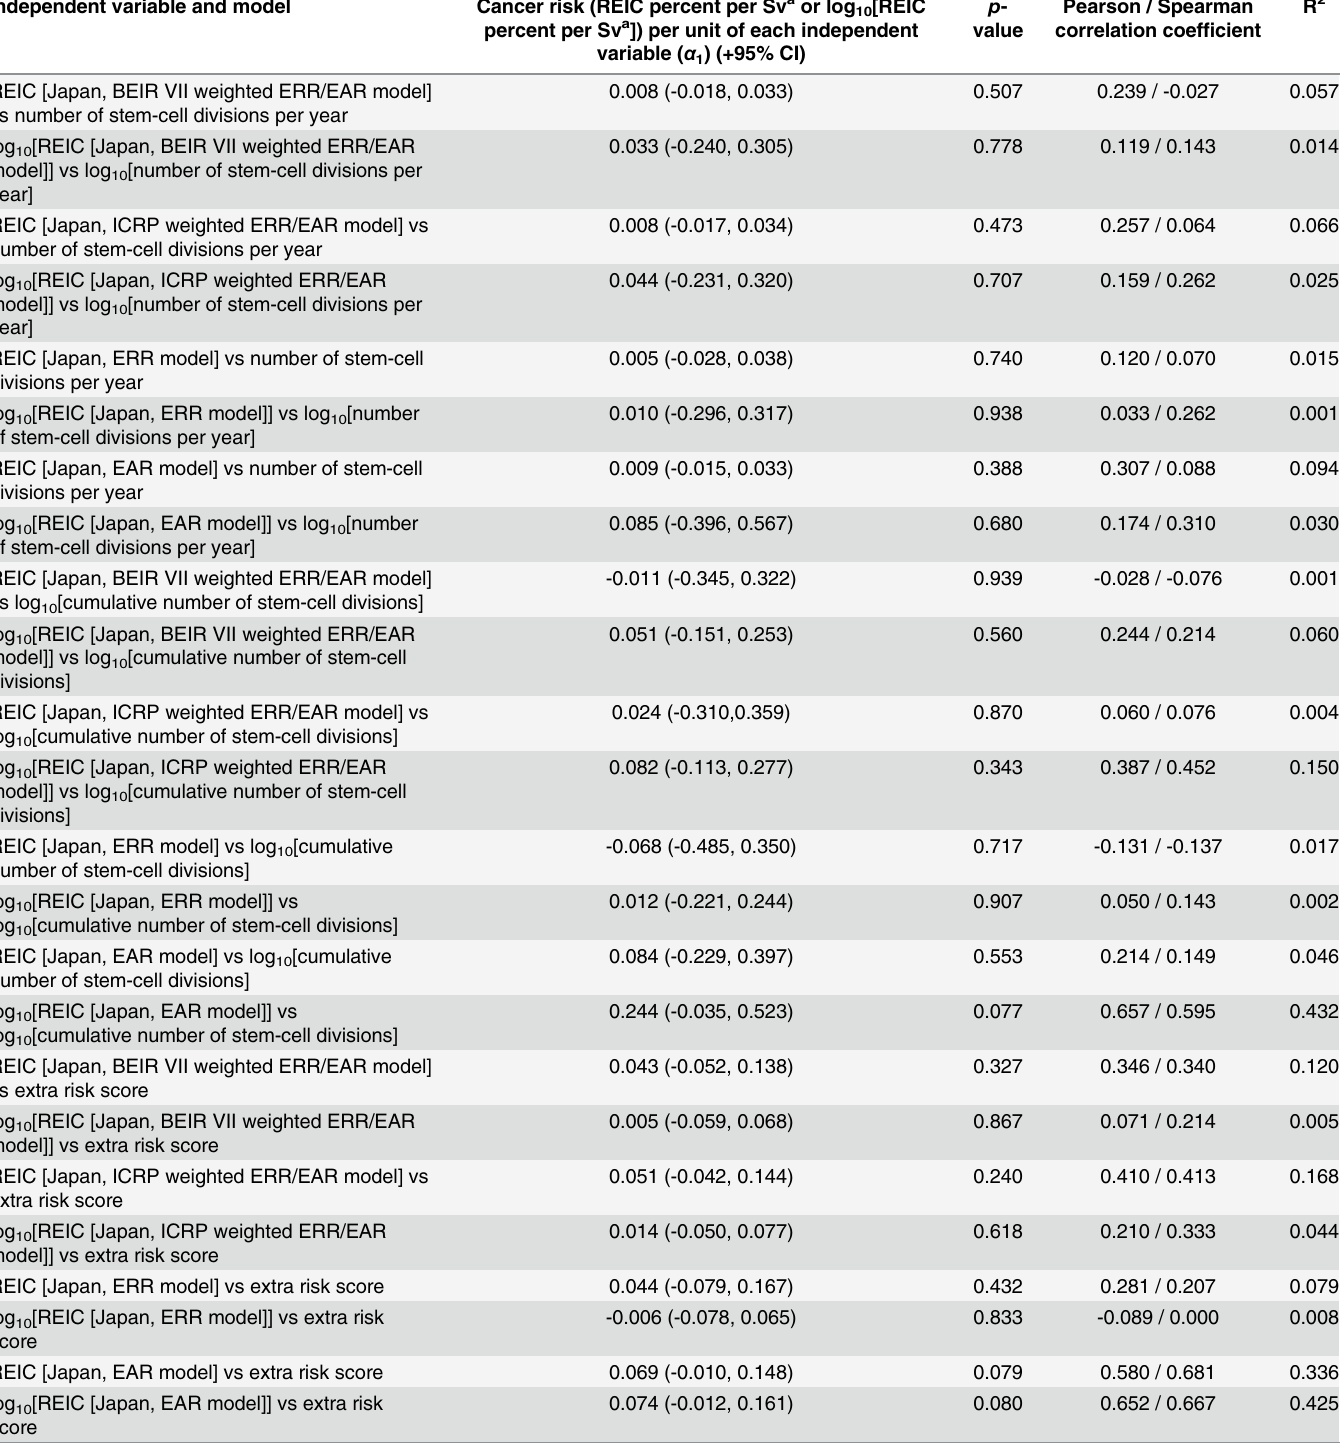
Table 4. Trends of linear regression model (11) fitted to radiation exposure-induced cancer incidence risk (REIC)(percent) (or log 10 [REIC]) with explanatory variables (a) numbers of stem-cell divisions per year (or log 10 [numbers of stem-cell divisions per year]), (b) log 10 [cumulative number of stem-cell divisions], (c) extra risk score (ERS) and (d) log 10 [number of stem-cells], using data of Tomasetti and Vogelstein [2], as in Table